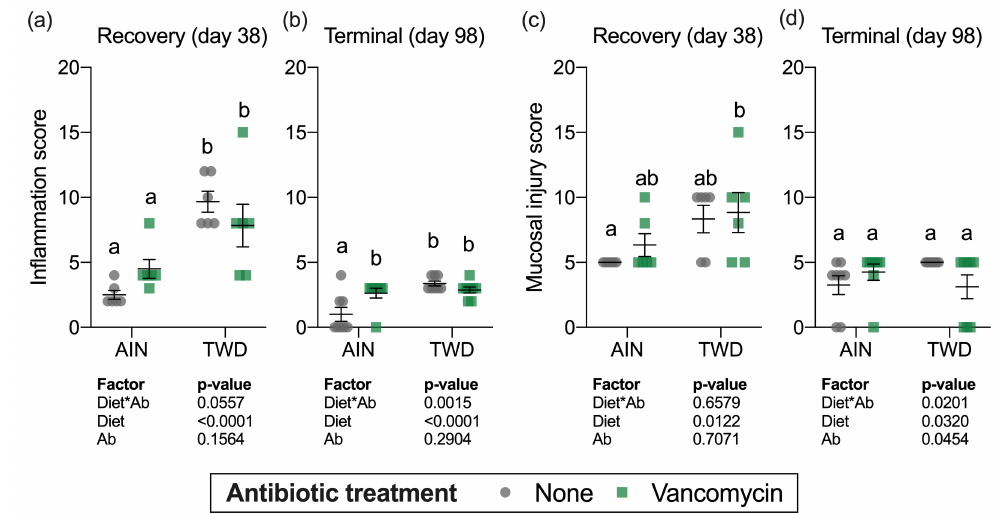
Figure 3 Figure 3. Histopathological assessment of mucosal inflammation ( a , b ) and mucosal injury ( c , d ). Values shown are the individual measurements for each animal with the mean ± standard error ( n = 6 for day 38, n = 8 for day 98). Main effects of experimental factors diet, antibiotic treatment and diet*antibiotic interaction are shown as determined by generalized linear mixed model, and different letters indicate experimental groups are significantly different ( p < 0.05) as determined by the Tukey HSD post hoc test. Abbreviations: AIN, the AIN93G diet; TWD, the total Western diet; Ab,